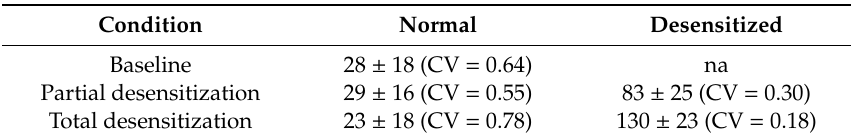
Table 12. Mean MNTs (in Newtons) measured over the heel bulbs in limbs with and without analgesia of the digital flexor tendon sheath [35].